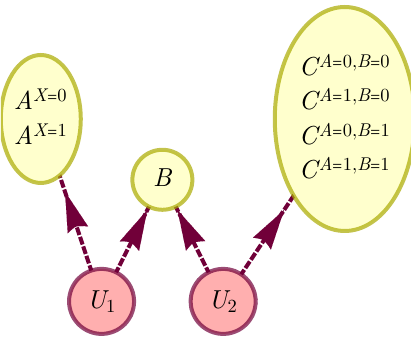
Figure 11: The unpacking of 𝒢 1 in Figure 10, which we denote by 𝒢 2